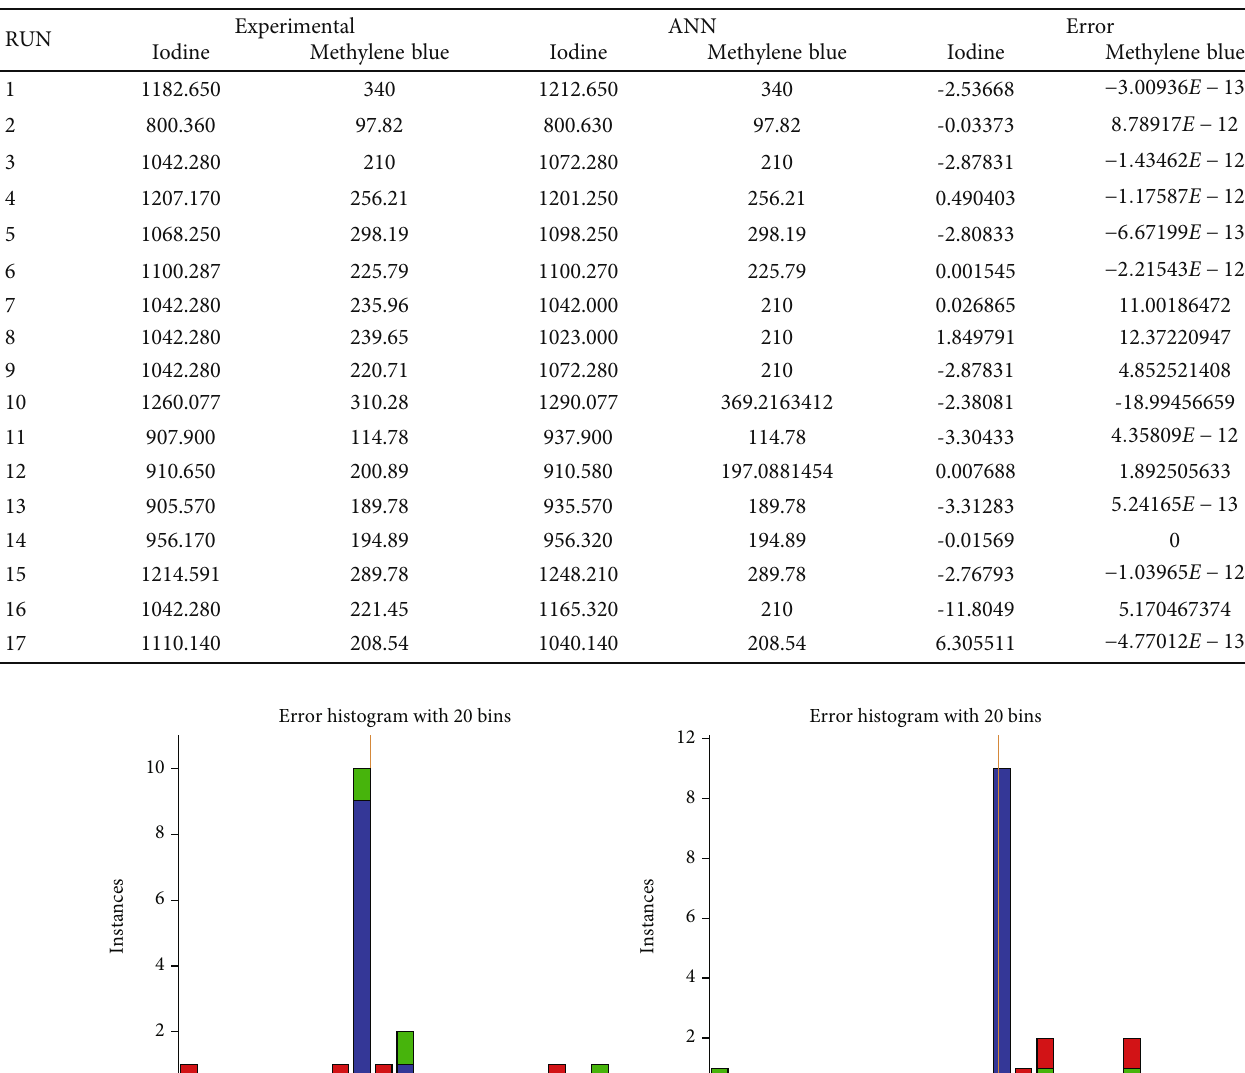
Table 4: Predicted error based on the comparison of experimental and ANN values.